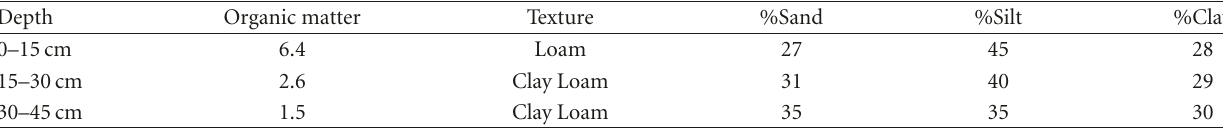
Figure 5: (a) The structure and installation of paper pipes . (b) Use of paper pipes in 10 cm-diameter and 90cm-depth holes for a temporary WUSN testbed. Table 1: Example of a soil analysis